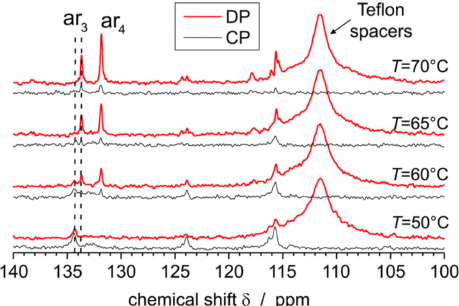
Figure 8. Aromatic signal region of 13 C MAS spectra of a 4:1 mixture of DPPC and B12, comparing direct polarization (DP) (upper, red) and cross-polarization (CP) (lower, black) spectra taken at the indicated temperatures. The resonances ar 3 and ar 4 correspond to aromatic CH groups marked with green up-triangles in the B12 structure in Figure 2. Figure reproduced with permission from ref. [23]. Copyright 2016 Americal Chemical